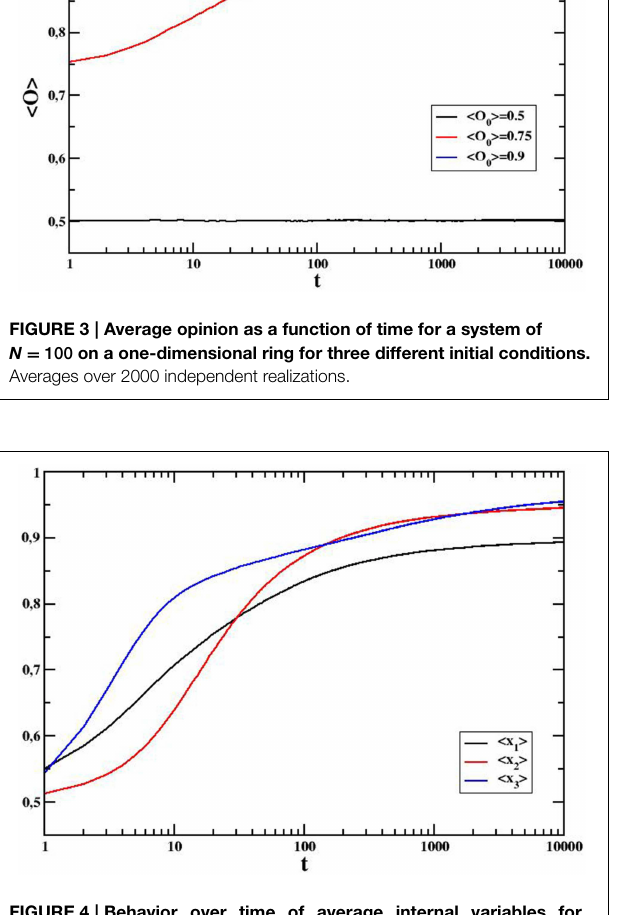
FIGURE 2 | Time behavior of average internal variables for a system of N = 100 on a totally connected graph and initial average opinion h O 0 i = 0 . 5 . Averages over 2000 independent realizations.